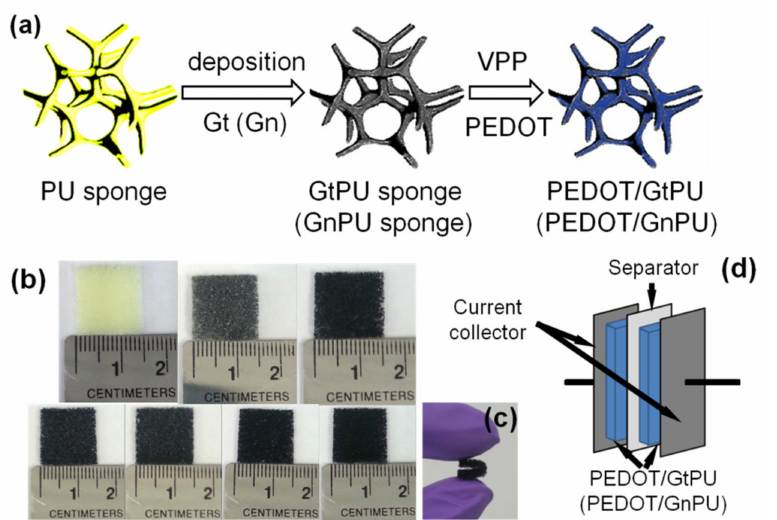
Figure 1. ( a ) Schematic illustration of the preparation of poly(3,4-ethylenedioxythiophene)/graphite nanoplatelet-deposited polyurethane (PEDOT/GtPU) and PEDOT/GnPU composite sponges. ( b ) The photographs of PU, GtPU and GnPU sponge (from left to right on the top), 50 PEDOT/GtPU, 110 PEDOT/GtPU, 50 PEDOT/GnPU and 110 PEDOT/GnPU composite sponge (from left to right at the bottom). ( c ) A bent strip of 50 PEDOT/GnPU composite sponge. ( d ) Schematic representation of the supercapacitor cell